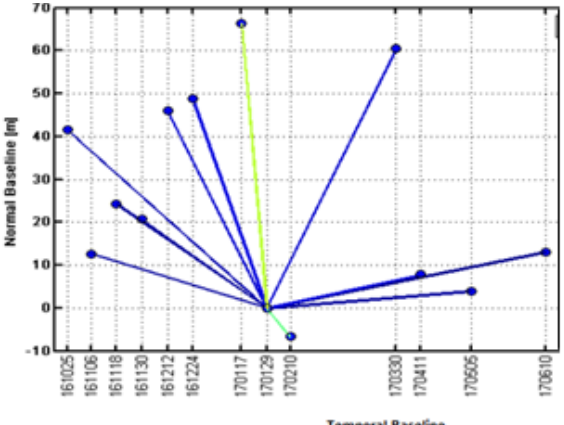
Figure 2: Baseline Dataset information of the acquired Sentinel- 1 datasets Figure 2 represents the dataset information. The master image chosen was 29 th January 2017. Normal baseline information is shown on Y-axis and the temporal baseline information on X- axis.